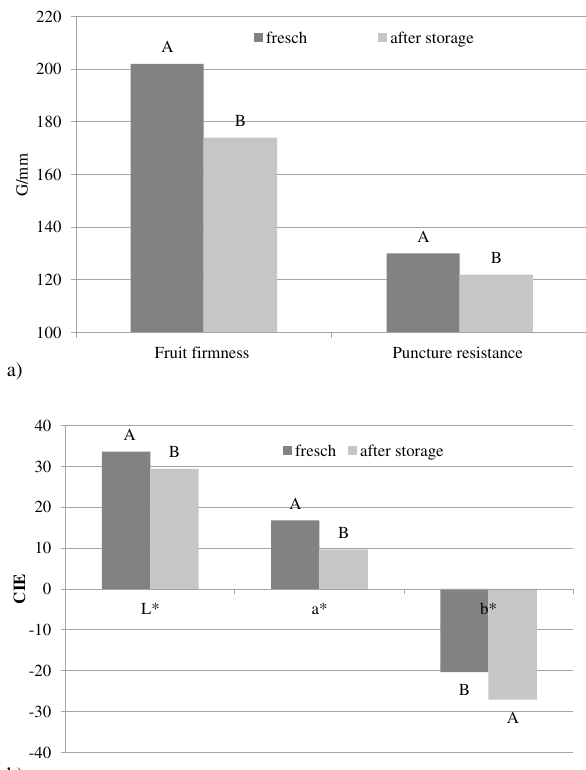
Figure 1. Changes in physical ( a ) and colour parameters ( b ) of highbush blueberry fruit after CA cold storage.